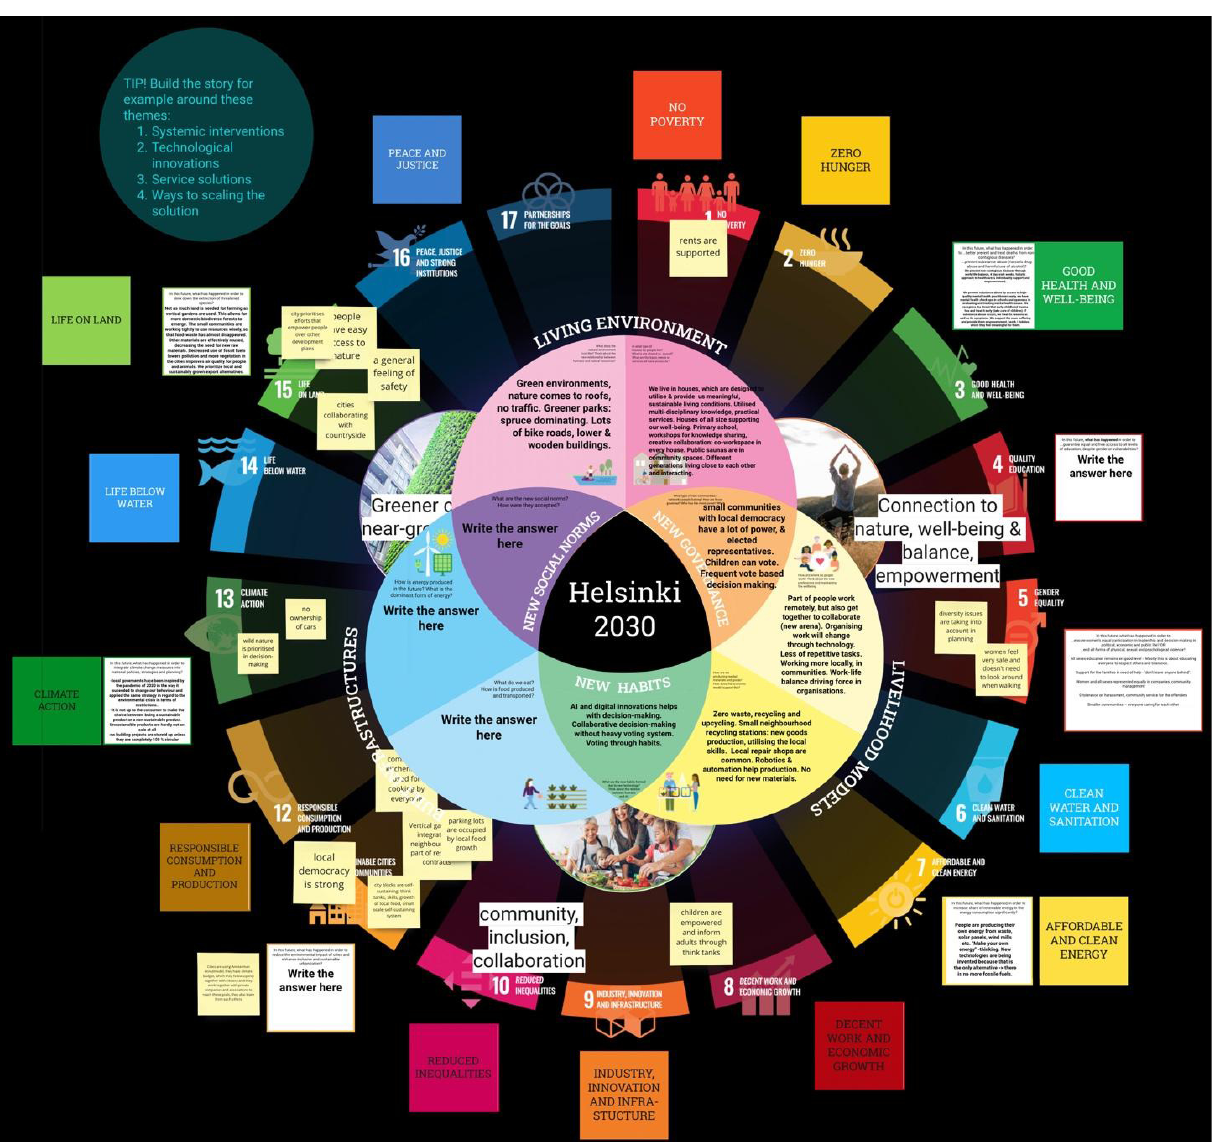
Figure 1. Part of the game board, including the contributions by players during one of the sessions testing the final iteration with an external